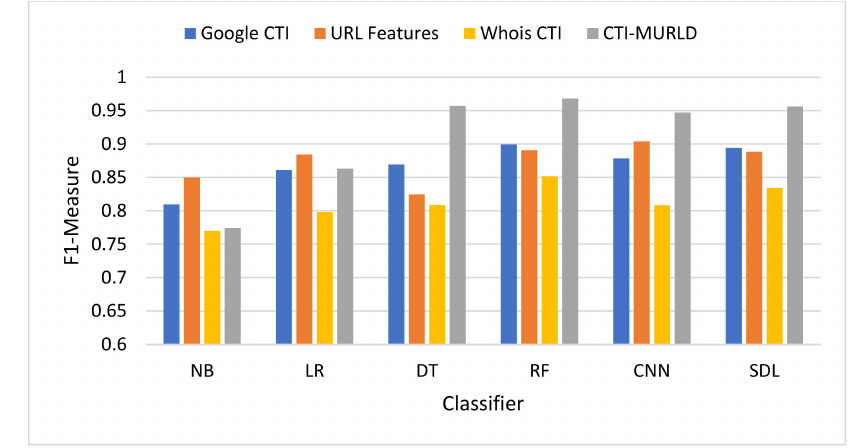
Figure 9. Comparison in terms of the